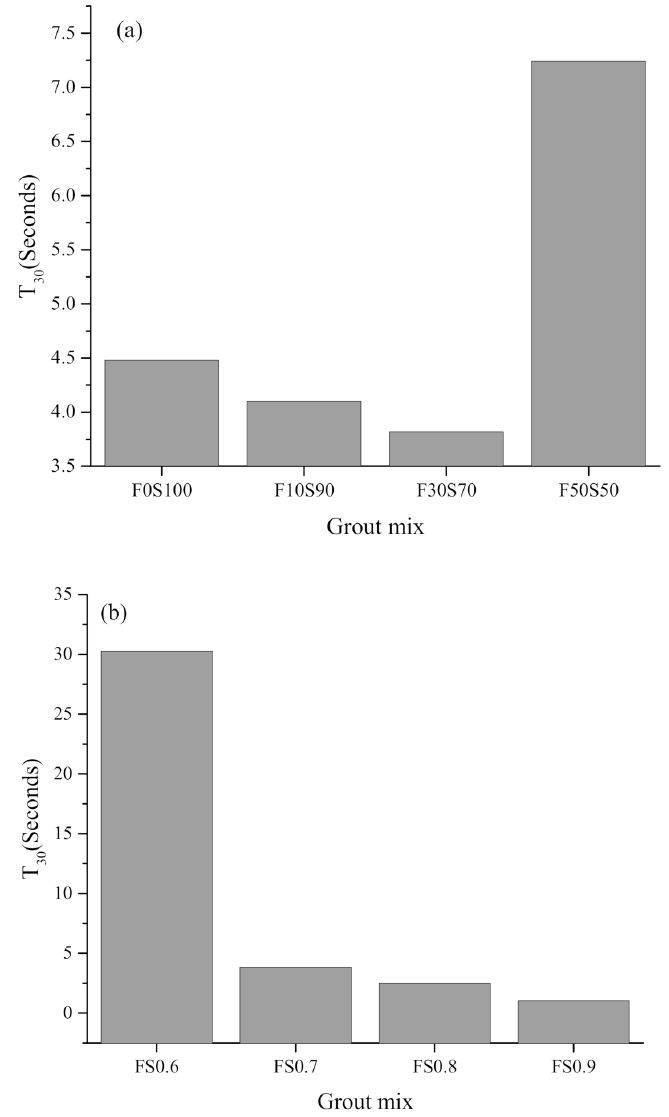
Figure 3. Flowability of alkali activated grout as observed by T 30 time: ( a ) Series 1 and ( b ) series